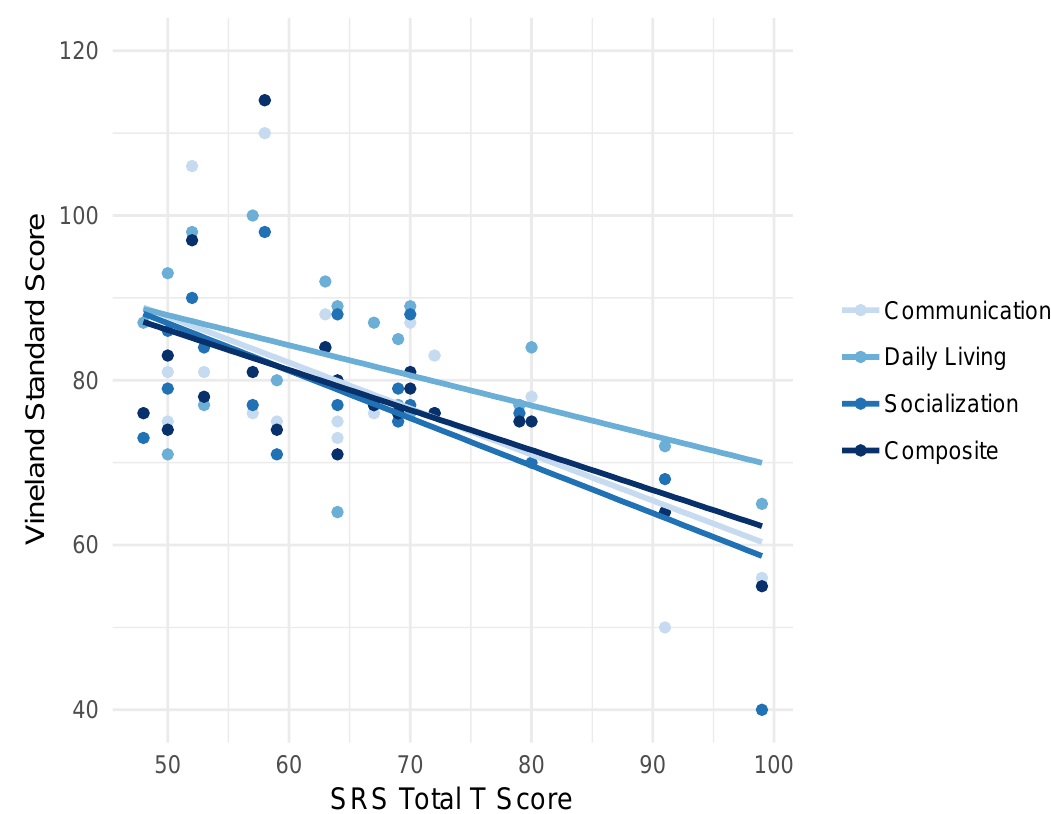
Figure 4. Correlations between social skills and adaptive behavior. Correlations between difficulties with social skills as measured by total score reported by caregivers on the Social Responsiveness Scale-2 (SRS) and the communication, daily living, and socialization subscales and overall adaptive behavior composite scores of the Vineland Adaptive Behavior Scales, Third Edition—Interview Form (VABS-III).